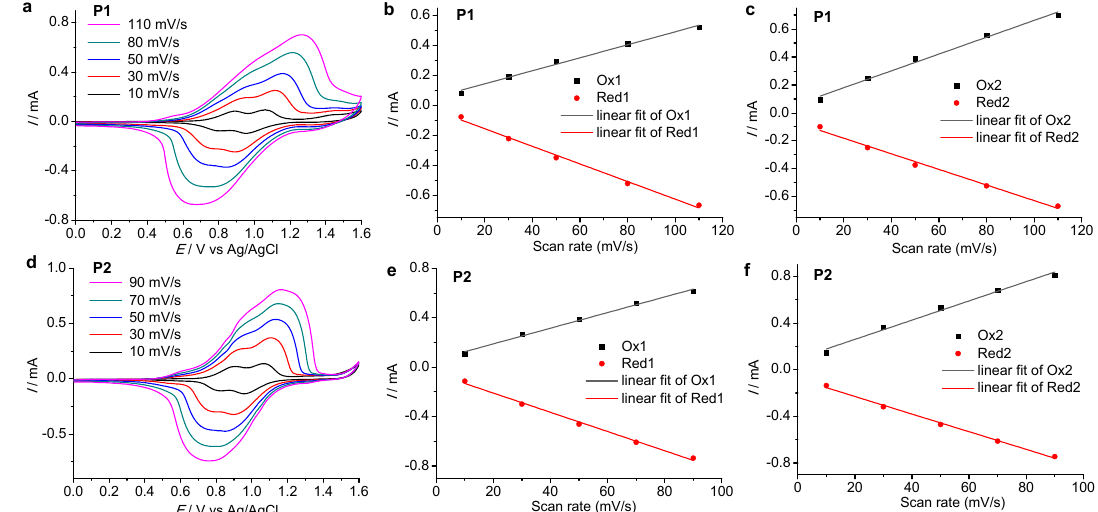
Figure 3. CVs obtained at different scan rates of ( a ) P1 (10, 30, 50, 80, and 110 mV/s, respectively) and ( d ) P2 (10, 30, 50, 70, and 90 mV/s, respectively). Linear dependence of peak currents of ( b , e ) the first redox wave and ( c , f ) the second redox wave of ( b , c ) P1 and ( e , f ) P2 as a function of scan rate. Ox1, Red1, Ox2, Red2 stand for the first oxidation, first reduction, second oxidation, and second reduction peak, respectively. The R 2 values are over 0.98 for all linear fit. The polymeric films on ITO glass electrode were used as the working electrode.